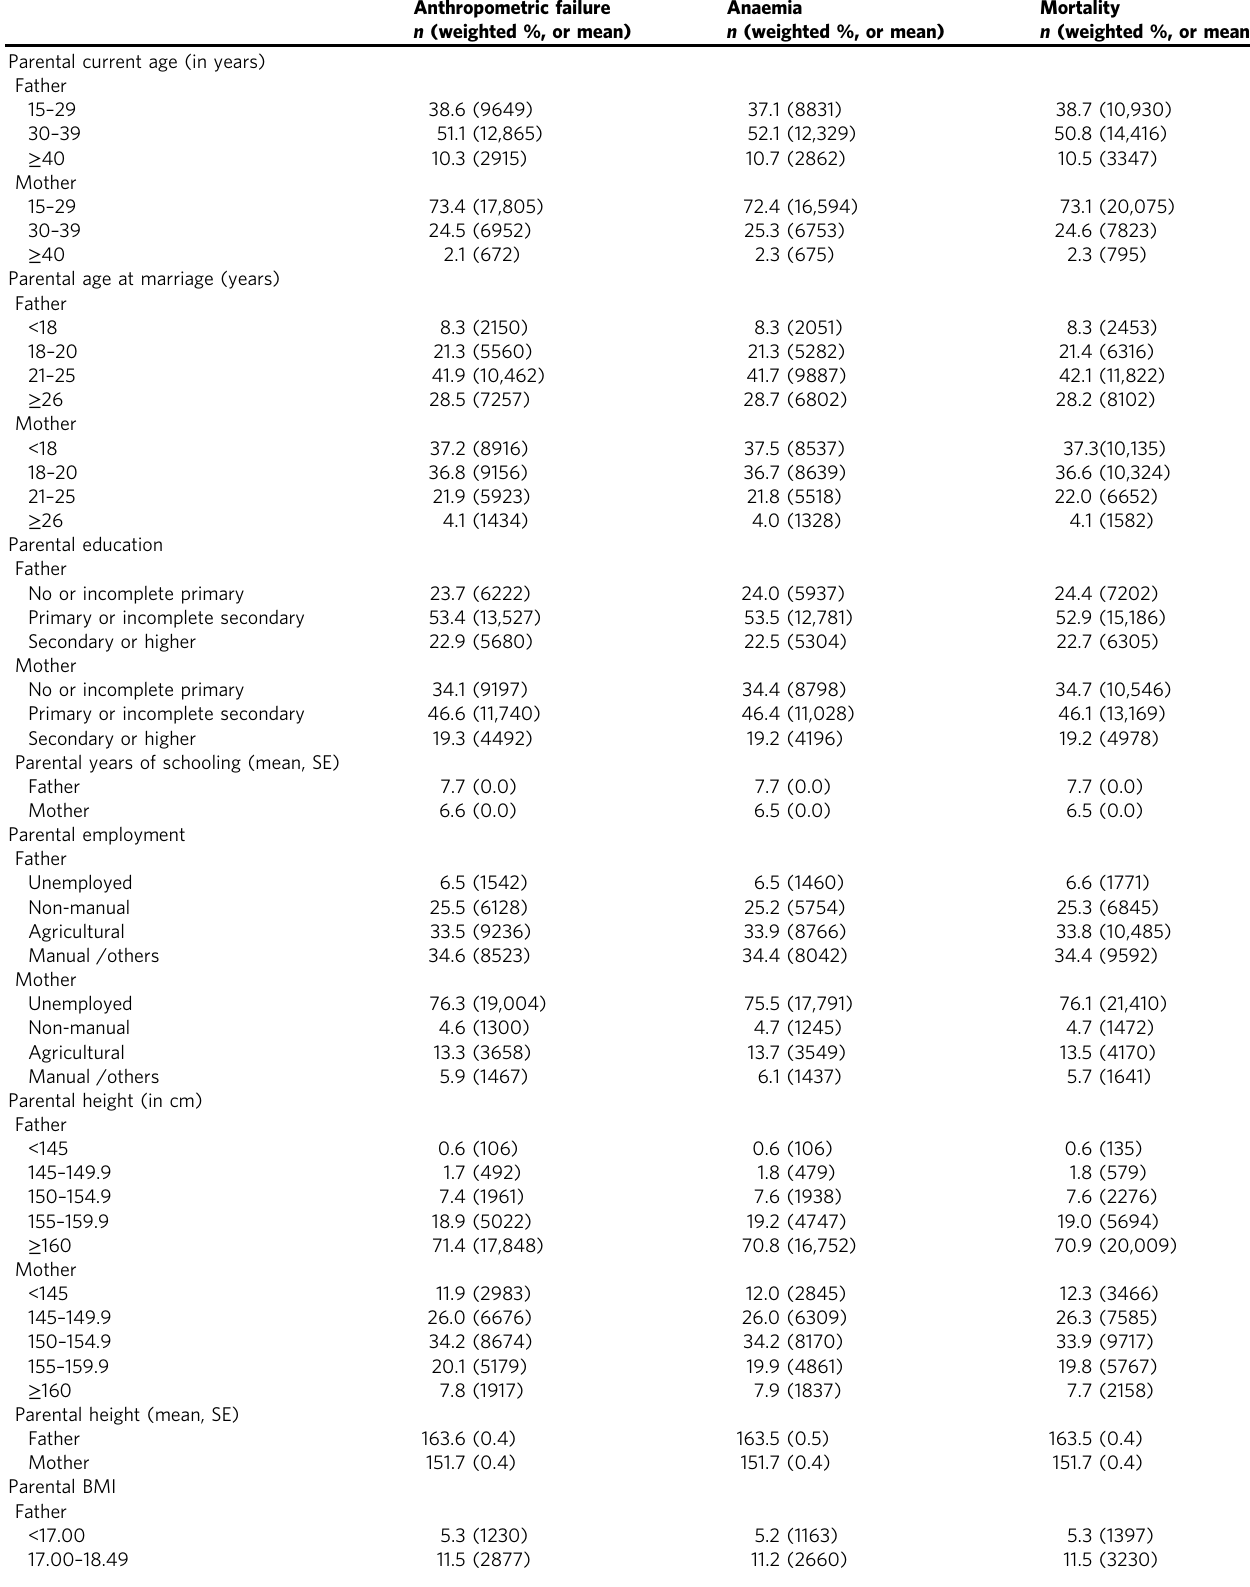
Table 1 Sample distribution of children selected to measure their anthropometric failure (aged 0 – 59 months), anaemia status (aged 6 – 59 months) and mortality (aged 0 – 59 months), by parental characteristics and other covariates. Anthropometric failure n (weighted %, or